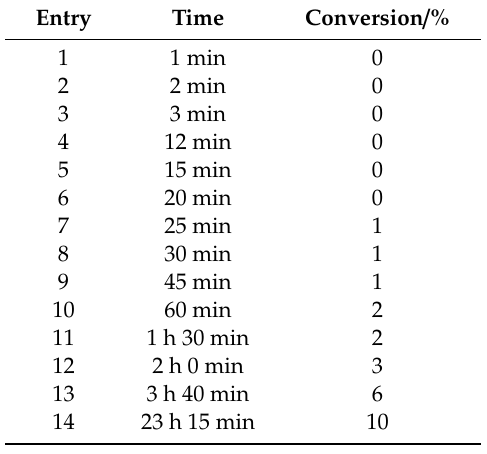
Table A7. Reduction of acetophenone ( 1 ) to 1-phenylethanol ( R )- 2 . Change from standard procedure: 24 h incubation of immobilized enzymes in superabsorber without organic solvent.